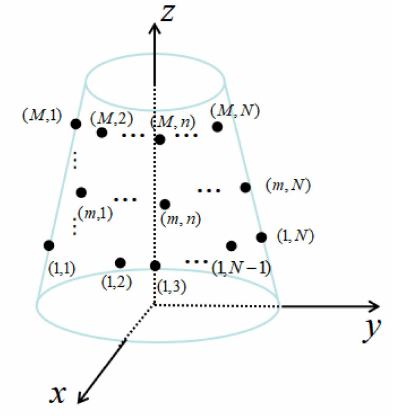
Figure 1. The geometry of a truncated cone sparse